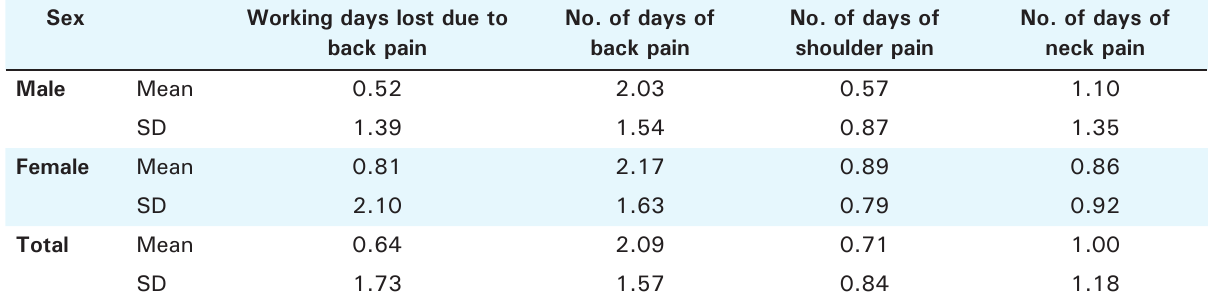
Gender Type of dentistry Frequent breaks Right posture